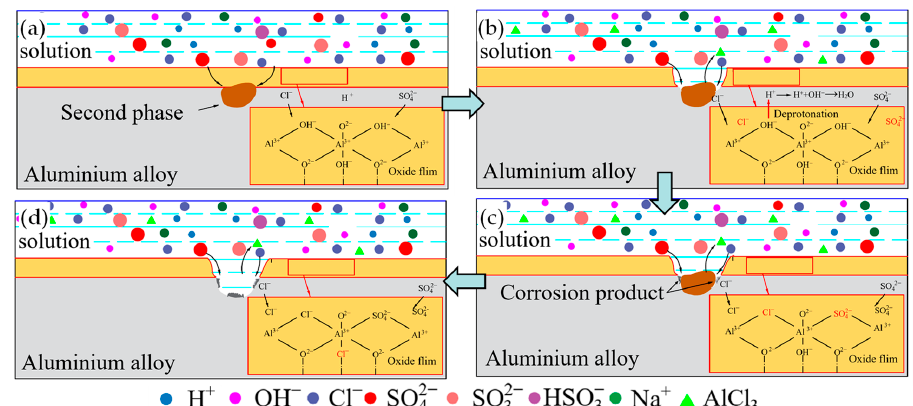
Figure 9. XPS spectra of the 5083/6005A welded joints corroded in the 3.5% NaCl + 0.01 mol/L Na- HSO 3 solution for 7 days: ( a ) 5083 and 6005A survey spectra; ( b ) 5083 Al2p spectrum; ( c) 6005A Al2p spectrum.